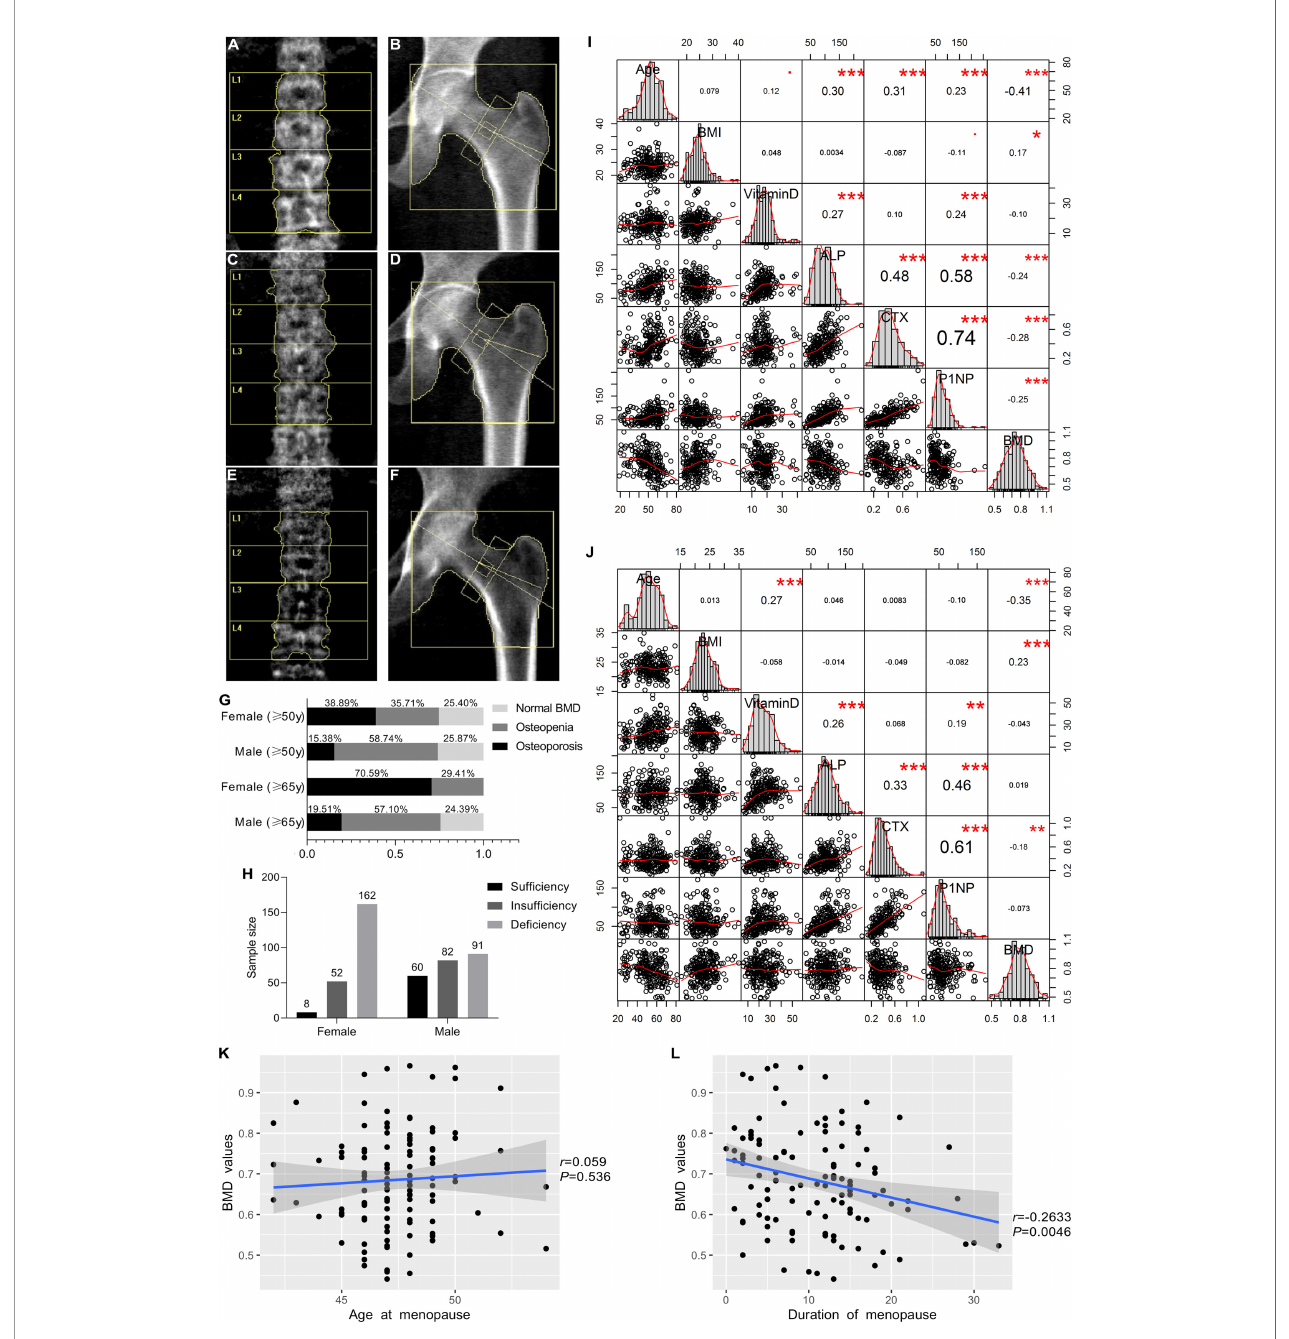
FIGURE 2 | DXA scan images of the BMD measurement and epidemiological investigation as well as correlation analysis of clinicopathological characteristics and BMD values. Lumbar spine (L 1 – 4 ) and total hip images in normal BMD group (A, B) , osteopenia (ON) group (C, D) , and osteoporosis (OP) group (E, F) . (G) Epidemiological investigation of OP and ON in females and males in our study. (H) Vitamin D de fi ciency and insuf fi ciency proportions. (I, J) Correlation analysis between clinicopathological characteristics and BMD values for female subjects and male subjects, respectively. This image presents bar graphs that show the distribution of variables as well as the scatter plots for two variables; the numbers in the image indicate the correlation coef fi cient of the two variables, while red dots and asterisks indicate the degree of statistical signi fi cance, (cid:129) 0.05 < P < 0.1, * P < 0.05, ** P < 0.01, *** P < 0.001. (K) Correlation between the menopausal age and BMD values in the females. (L) Correlation between the duration of menopause and BMD values in the